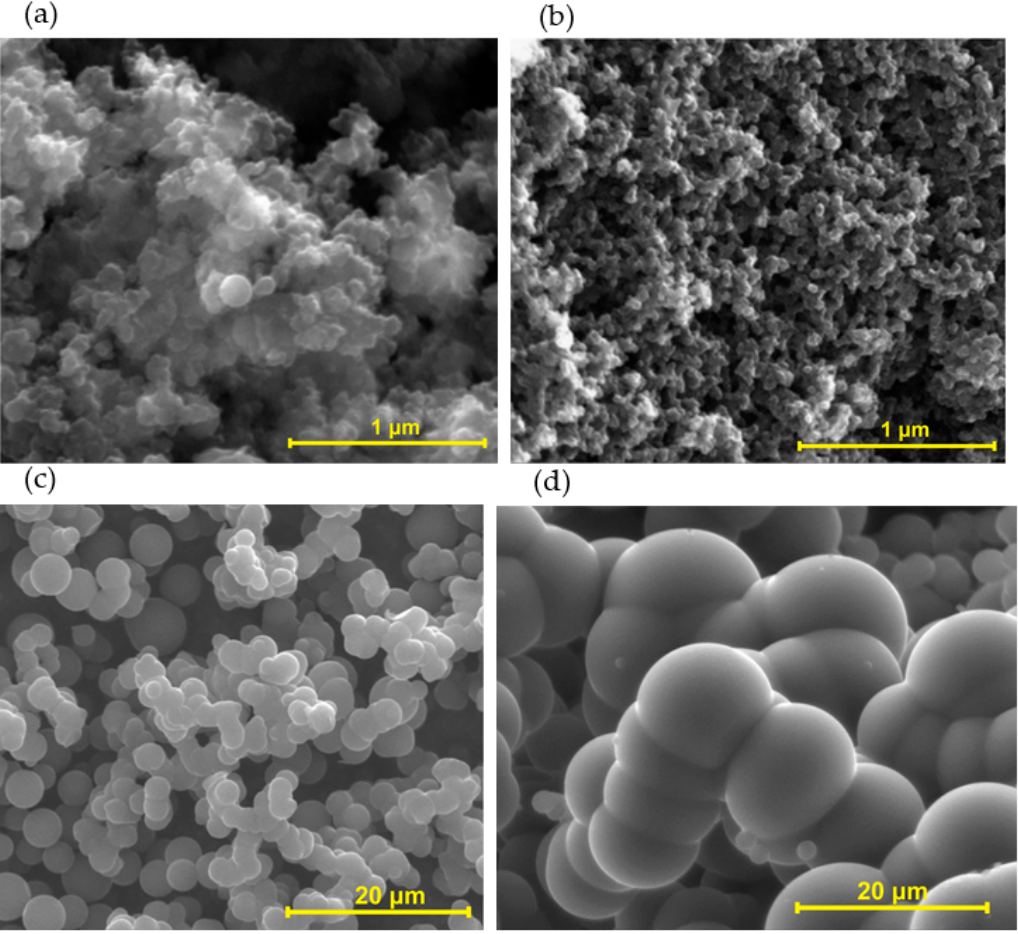
Figure 13. Tannin-formaldehyde carbon aerogels prepared under normal conditions at pH 3.3 ( a ) and pH 8.3 ( b ) (Reprinted with permission from reference [77] Copyright 2011 Elsevier); and hydrothermal carbon gels prepared with tannin solution at pH 2 ( c ) (Reprinted with permission from reference [106] Copyright 2015 Elsevier) and at non-modified pH (4.2) ( d ) [114].